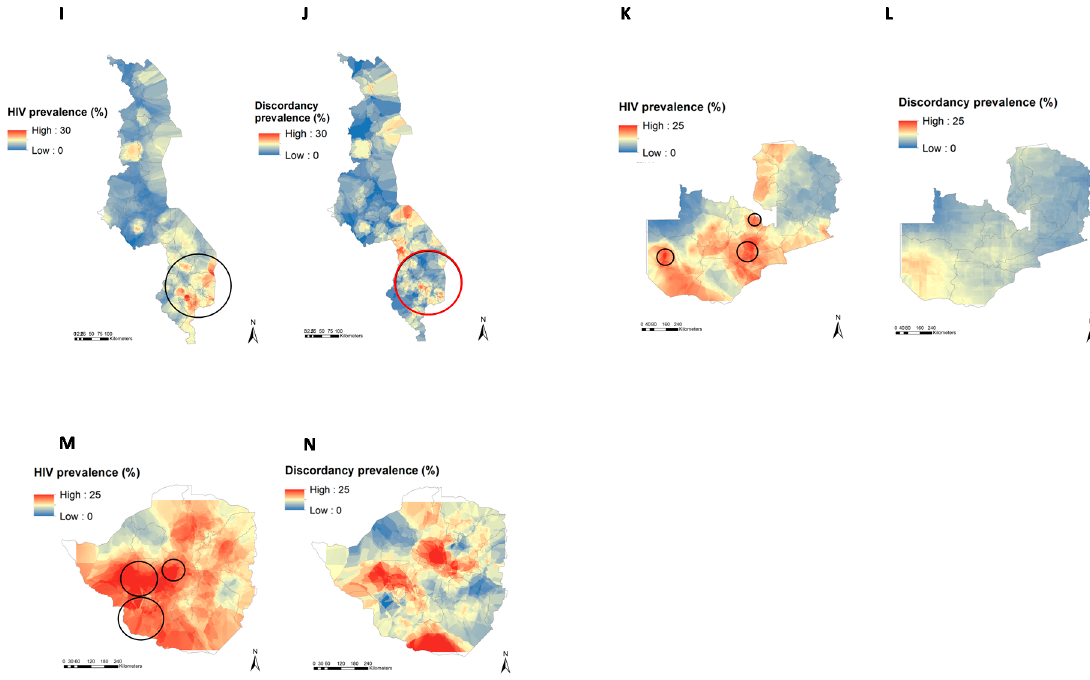
Figure 1. Geographical clustering of the number of HIV infections and the number of HIV sero-discordant partnerships in Cameroon, Kenya, Lesotho, Tanzania, Malawi, Zambia, and Zimbabwe. Black circles delineate spatial locations of high HIV prevalence clusters and red circles delineates high HIV SDP clusters in Cameroon ( A , B ), Kenya ( C , D ), Lesotho ( E , F ), Tanzania ( G , H ), Malawi ( I , J ), Zambia ( K , L ), and Zimbabwe ( M , N ). Continuous surfaces of HIV prevalence ( A , C , E , G , I , K , M ) and sero-discordant partnership prevalence ( B , D , F , H , J , L , N ) within a country were generated using the inverse distance weighted mapping algorithm [23].